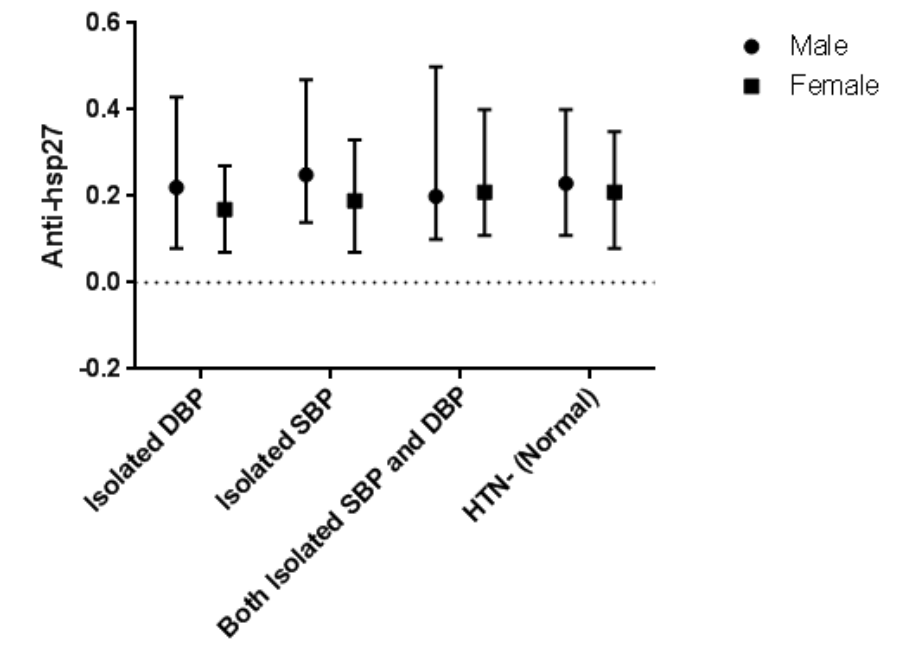
Figure 1. Comparison of serum anti-Hsp27 antibody titers in patients with Isolated Systolic Blood Pressure (SBP): (SBP≥140 & DBP<90), Isolated Diastolic Blood Pressure (DBP): (SBP<140 & DBP≥90), Both Isolated SBP and DBP: (SBP≥140 & DBP≥90), Hypertension (HTN)-: (SBP<140 &